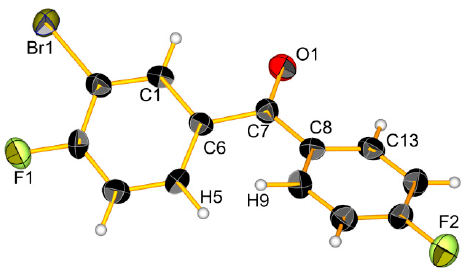
Figure 2. View of the molecular structure of 3 in ellipsoid 50% probability.